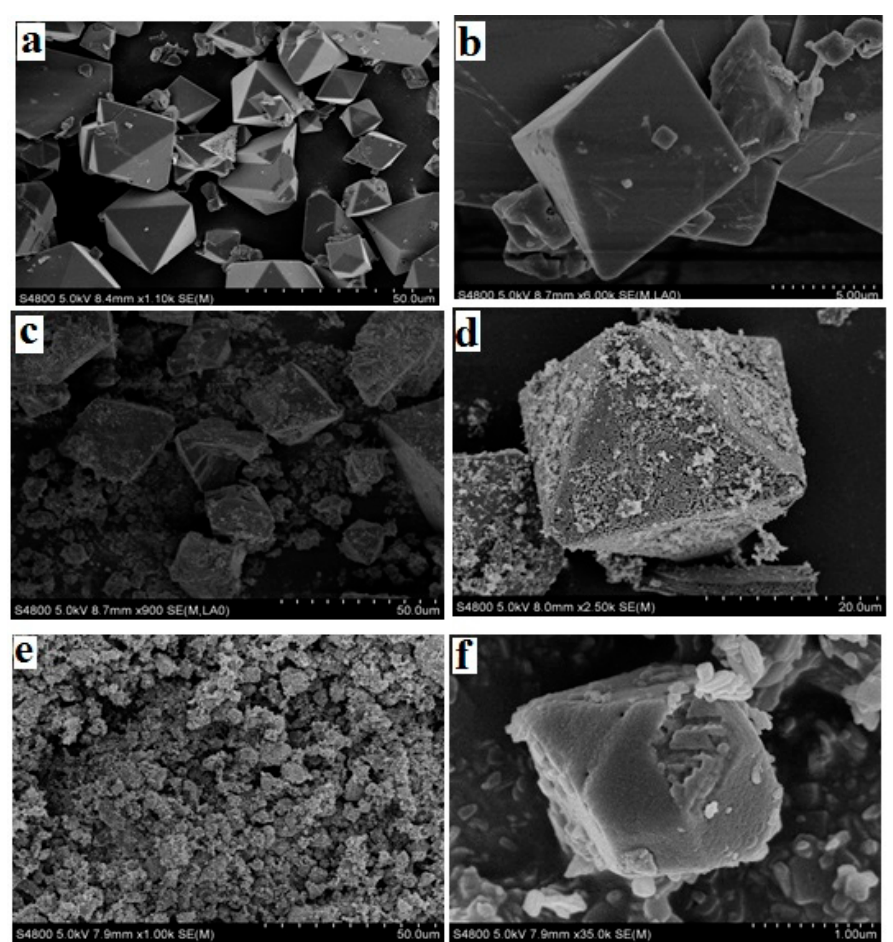
Figure 1. Scanning electron microscope (SEM) images of the surface of ( a , b ) pristine Cu-BTC, ( c , d ) NH 2 -Cu-BTC and ( e , f ) sub-NH 2 -Cu-BTC. Note BTC = 1,3,5-benzenetricarboxylic acid